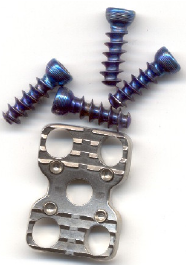
Figure 5: Surgical titanium plate and